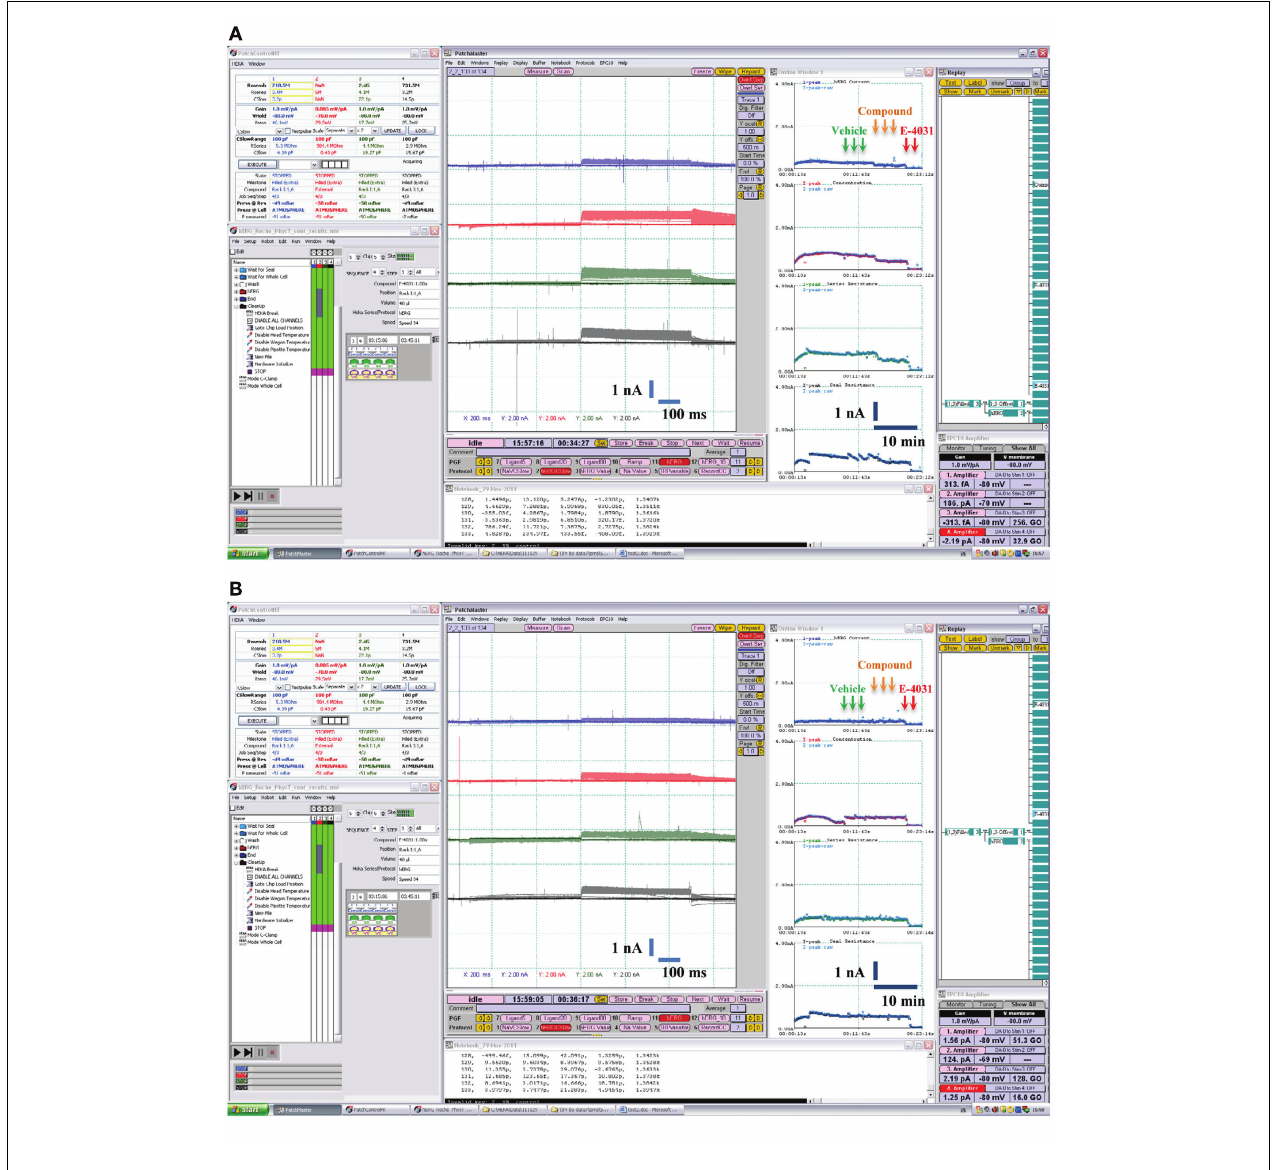
hERG K + current to the right. Arrows indicate compound additions for vehicle (0.1% v/v DMSO), test item single concentration [0.3 μ M quinidine in (A) and 6 μ M glibenclamide in (B) ] and positive control (1 μ M